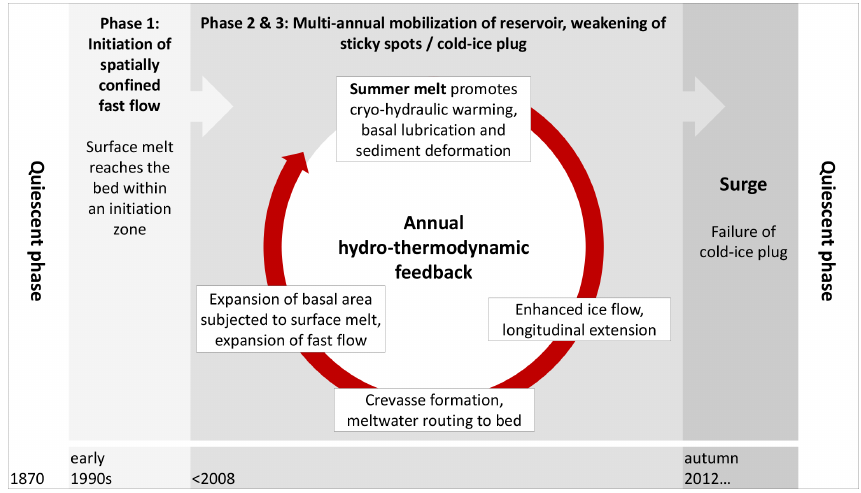
Figure 5. Schematic illustration of the proposed hydro-thermodynamic feedback to summer melt, imbedded within the surge cycle of Basin-3, Austfonna. The approximate start of each phase is indicated at the bottom. Phase 1 follows from long-term changes in glacier geometry, i.e. build-up of a reservoir, and associated changes in driving stress and basal thermal regime. The hydro-thermodynamic feedback loop operates over several years during phase 2 and 3, each loop coinciding with consecutive summer melt periods. Successive mobilization and destabilization initiates the surge. Dynamic thinning, reduction in driving stress and basal heat dissipation eventually terminate the